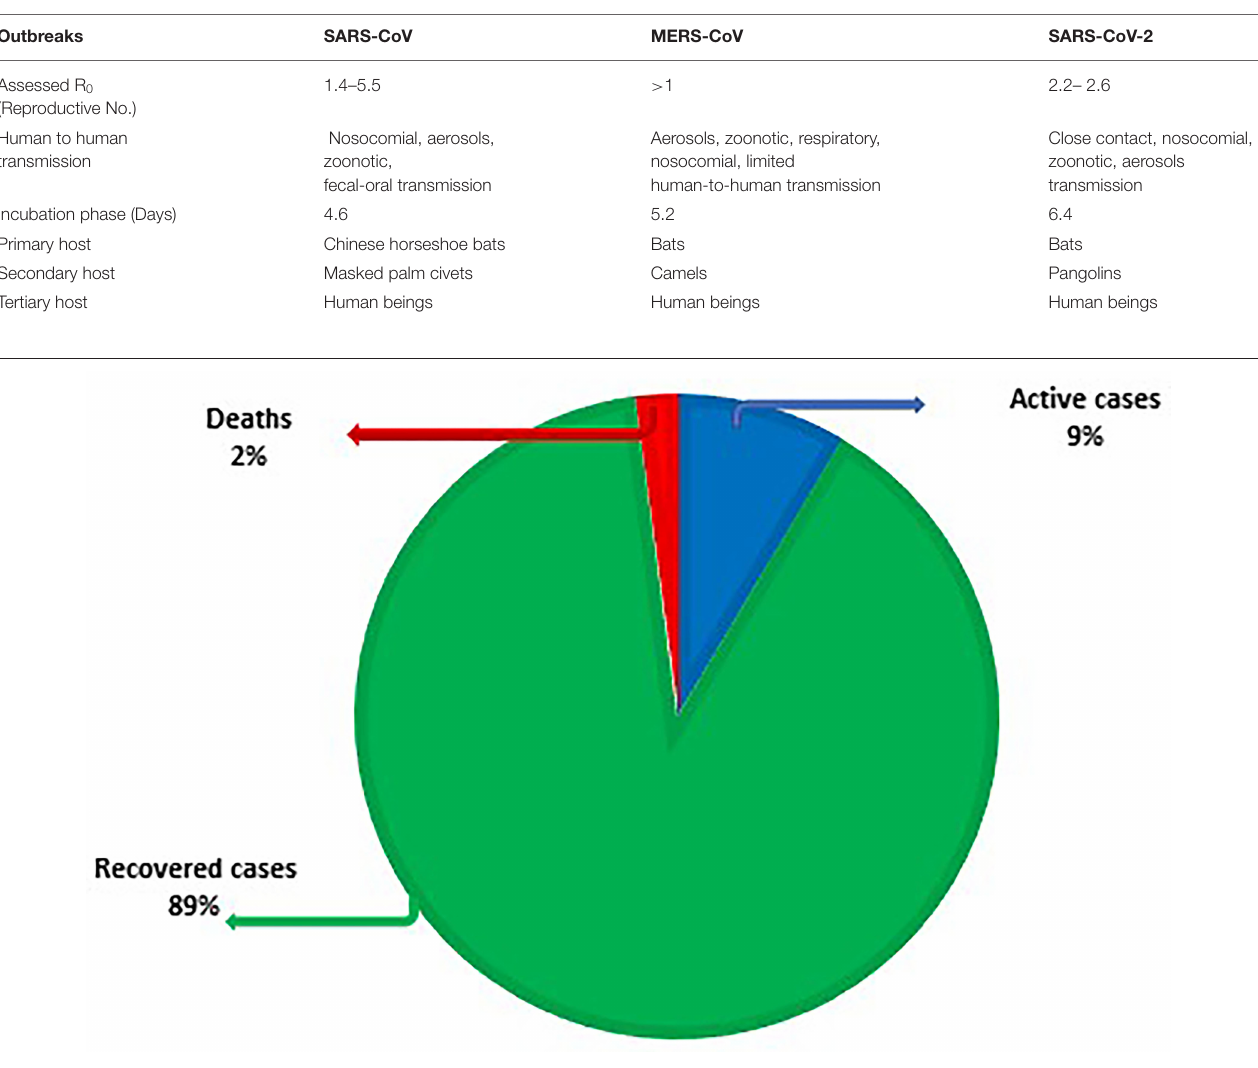
FIGURE 3 | Allocation prototype for recovered, active cases and deaths globally as on 2nd Sep